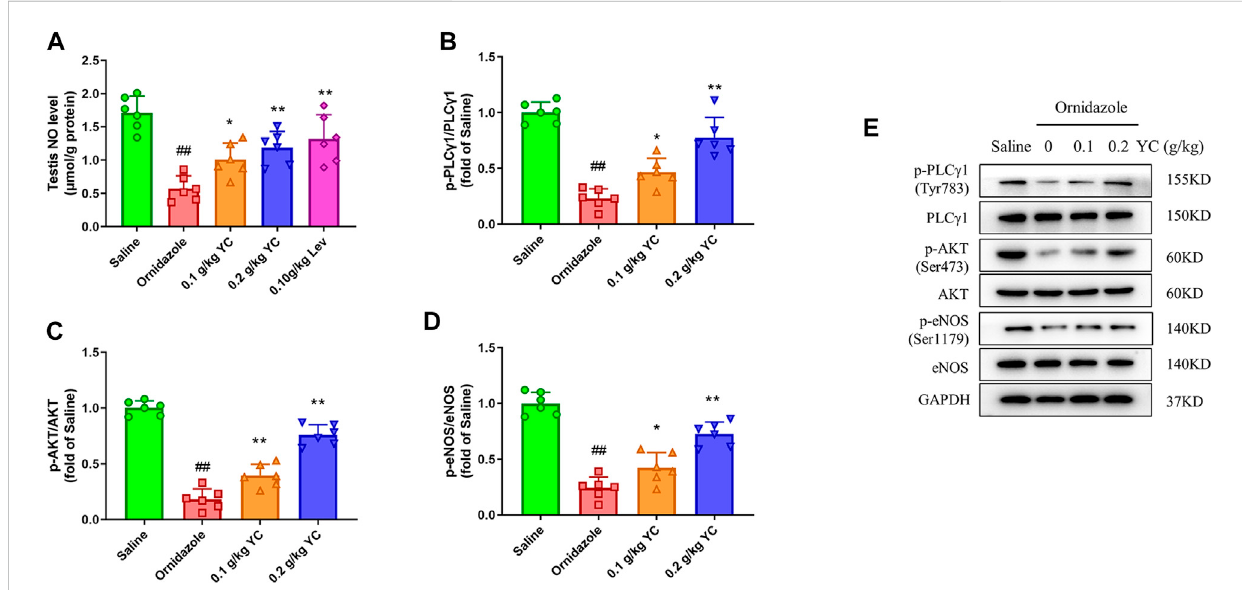
FIGURE 4 Nitric oxide (NO) concentrations and protein expression of PLC γ 1/AKT/eNOS signaling in the testis. (A) NO levels in the testes were measured by usingthecorrespondingcommercialkit. (B – E) Proteinexpressionofp-PLC γ 1,p-AKTandp-eNOSinthetestis.Valuesareshownasaverages±SD( n =6).